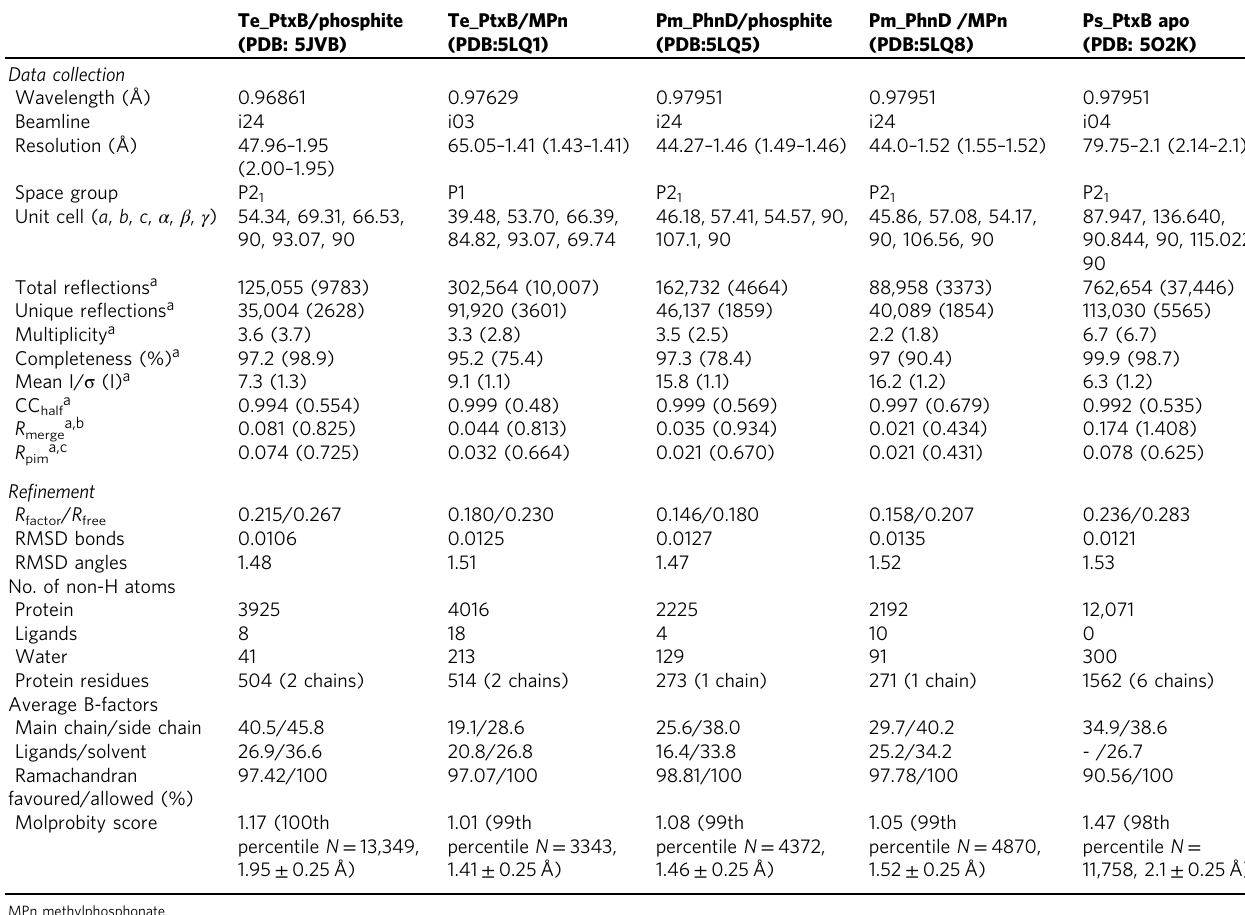
Table 2 Data collection and re fi nement statistics part